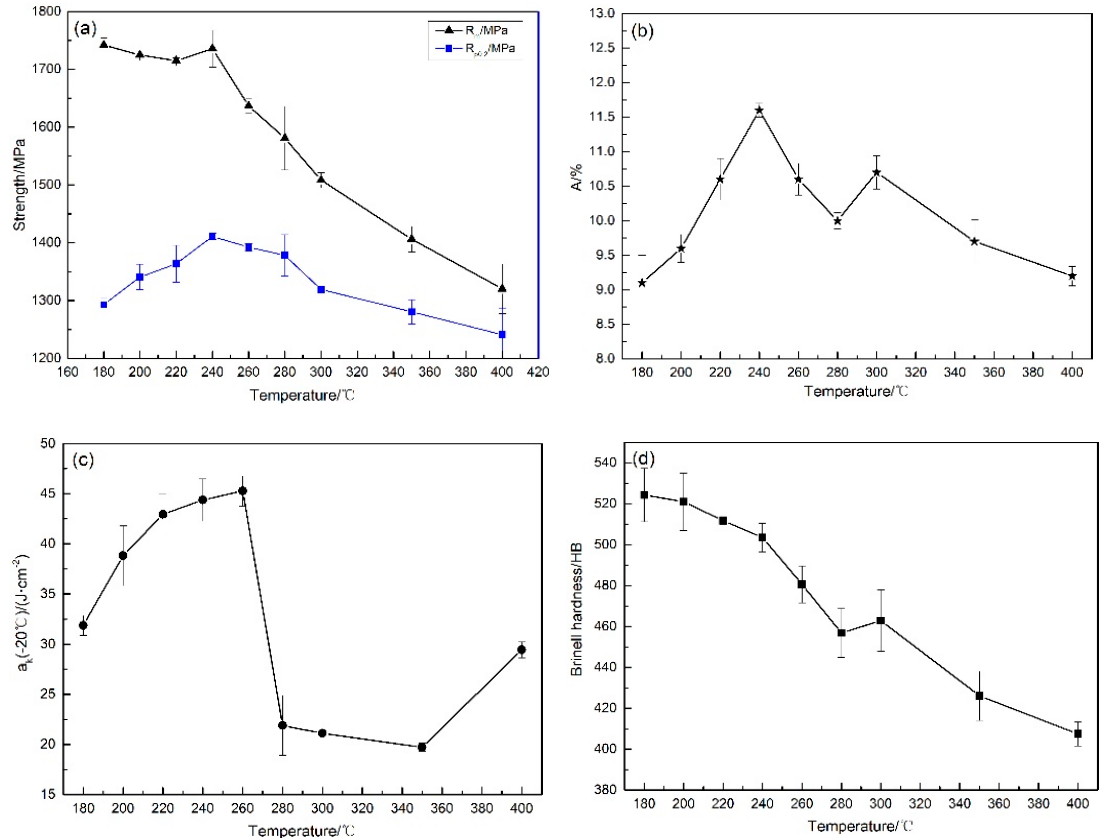
Figure 4. Mechanical properties of the test steels tempered at different temperatures: ( a ) tensile strength (R m ) and yield strength (R p0.2 ); ( b ) elongation (A); ( c ) impact toughness ( − 20 °C); ( d ) Brinell hardness.